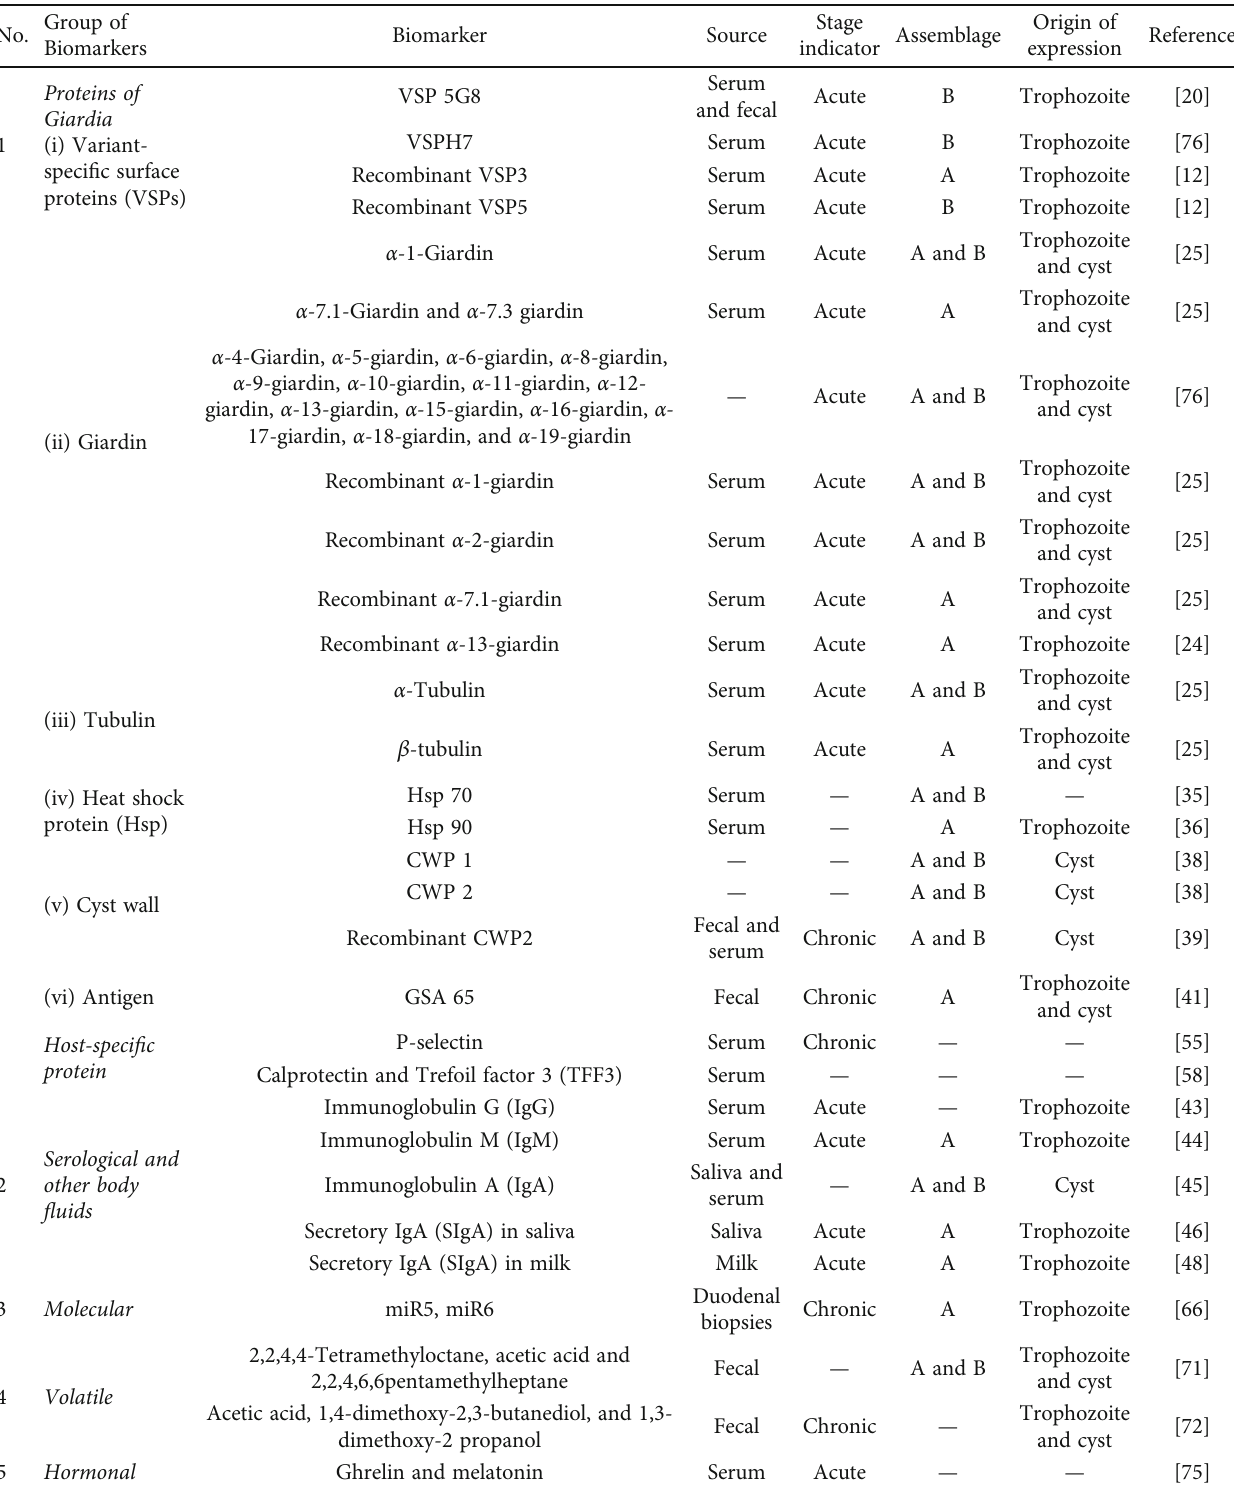
Table 1: The potential biomarkers associated with